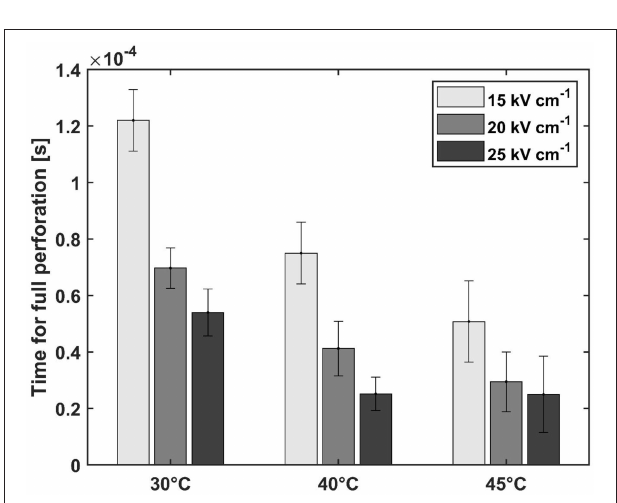
FIGURE 3 | Treatment time needed for full perforation ( Z D = 1) at electric field strengths that led to full permeabilization at all treatment temperatures. The error bars represent the standard deviation between two biological repetitions (repetition of the measurement on 2 days).